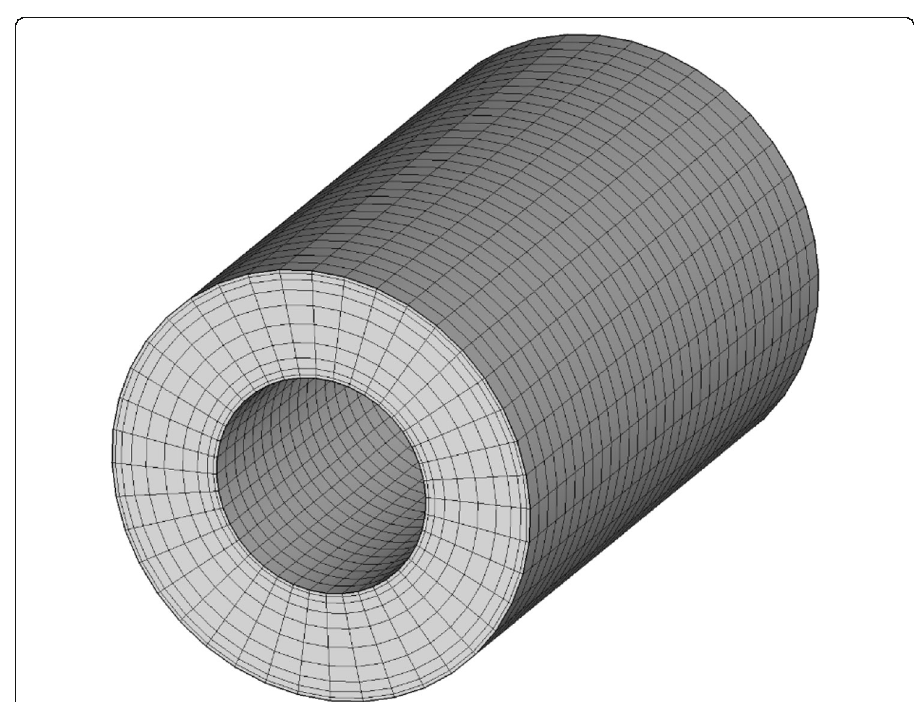
Fig. 11 Level 1 mesh for the hp-refinement study